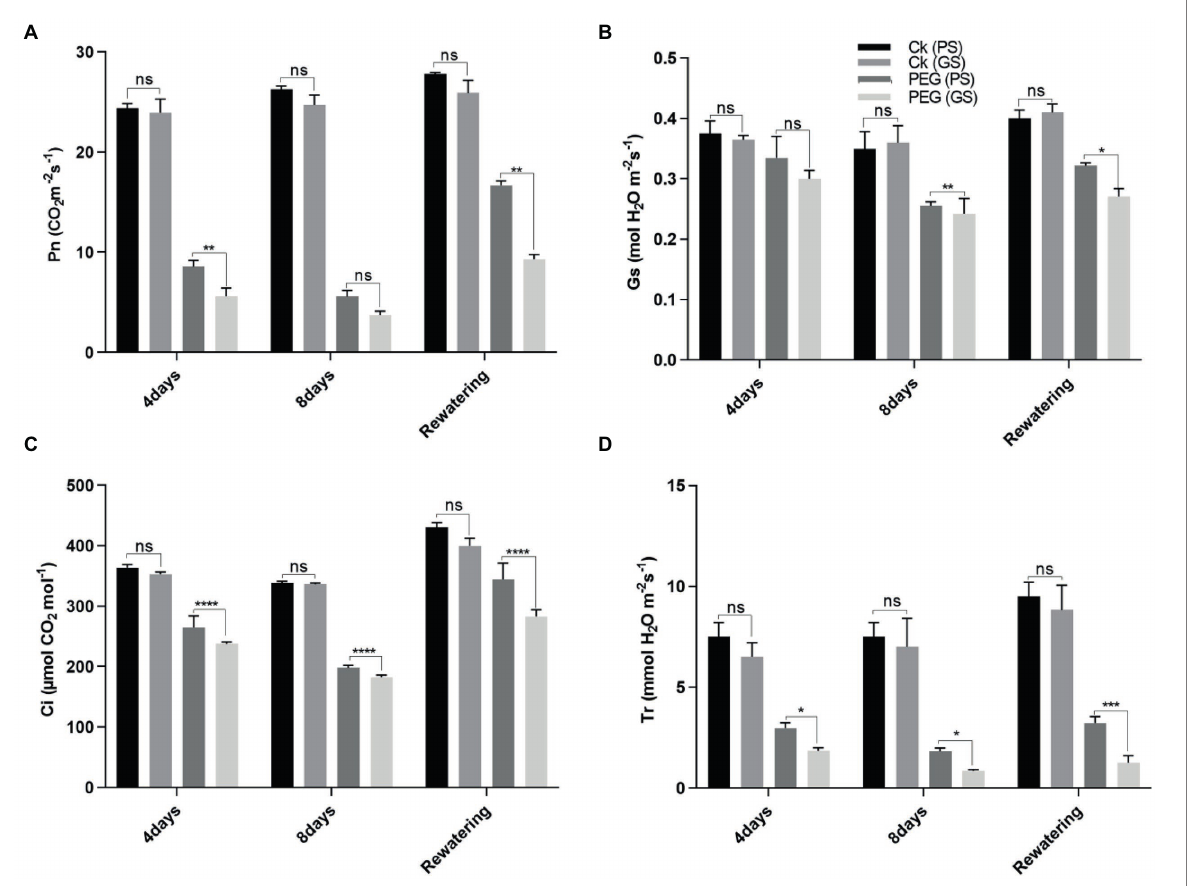
FIGURE 3 Purple and green stem Brassica napus plants under drought (10% PEG-6000), (A) net photosynthesis (Pn), (B) stomatal conductance (Gs), (C) corban dioxide intake (CI), and (D) transpiration rate, respectively. Different symbols represents significance level as * p = 0.05, ** p =